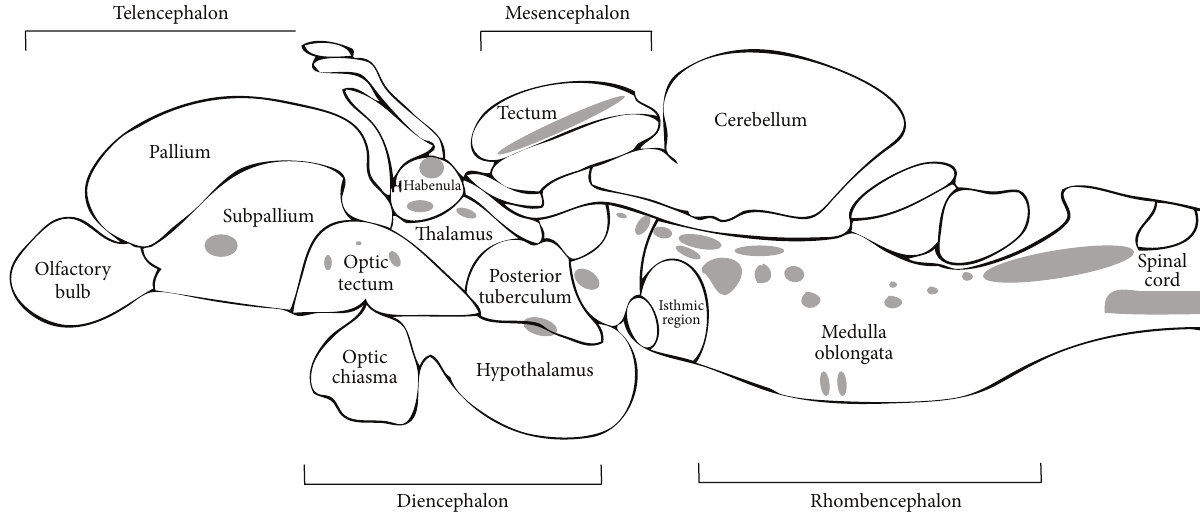
Figure 3: Schematic illustration of location of central nervous cholinergic neuronal populations (gray regions) in adult zebrafish brain (adapted from